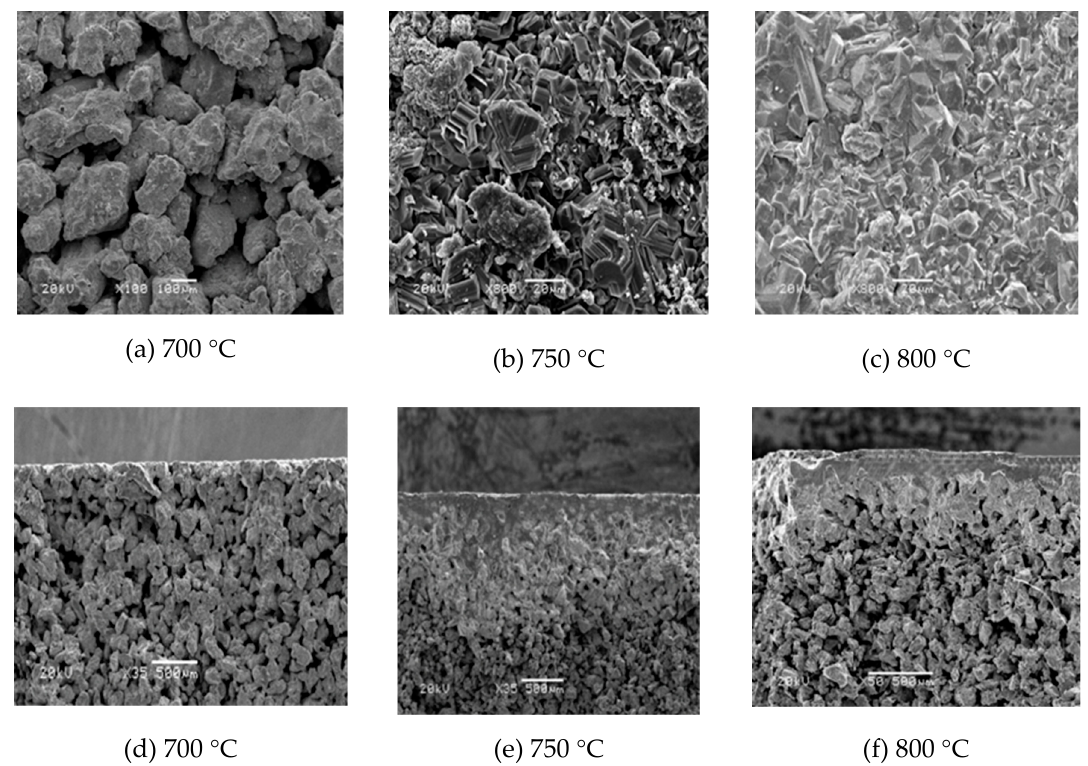
Figure 7. The surface and cross-section of Ti support after oxidation under N 2 :O 2 = 2:1, for 60 min at different temperatures.